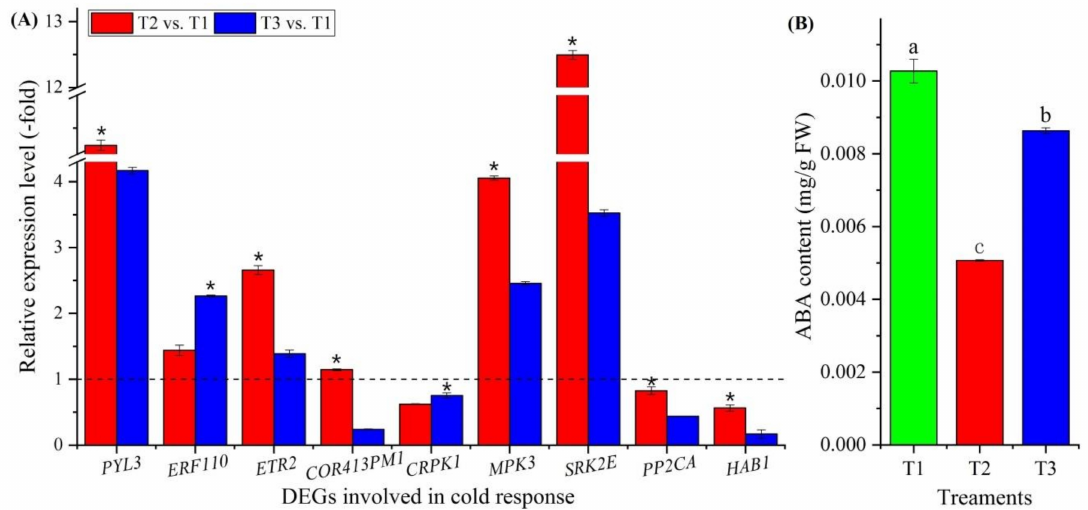
Figure 10. Expression levels of 9 genes involved in cold response ( A ) and changes in ABA contents at T1, T2 and T3 ( B ). Here and below, “*” represents a significant difference at the p < 0.05 level between T2 vs. T1 and T3 vs. T1 for the same gene; the use of different letters represents a significant difference ( p < 0.05) at different temperature